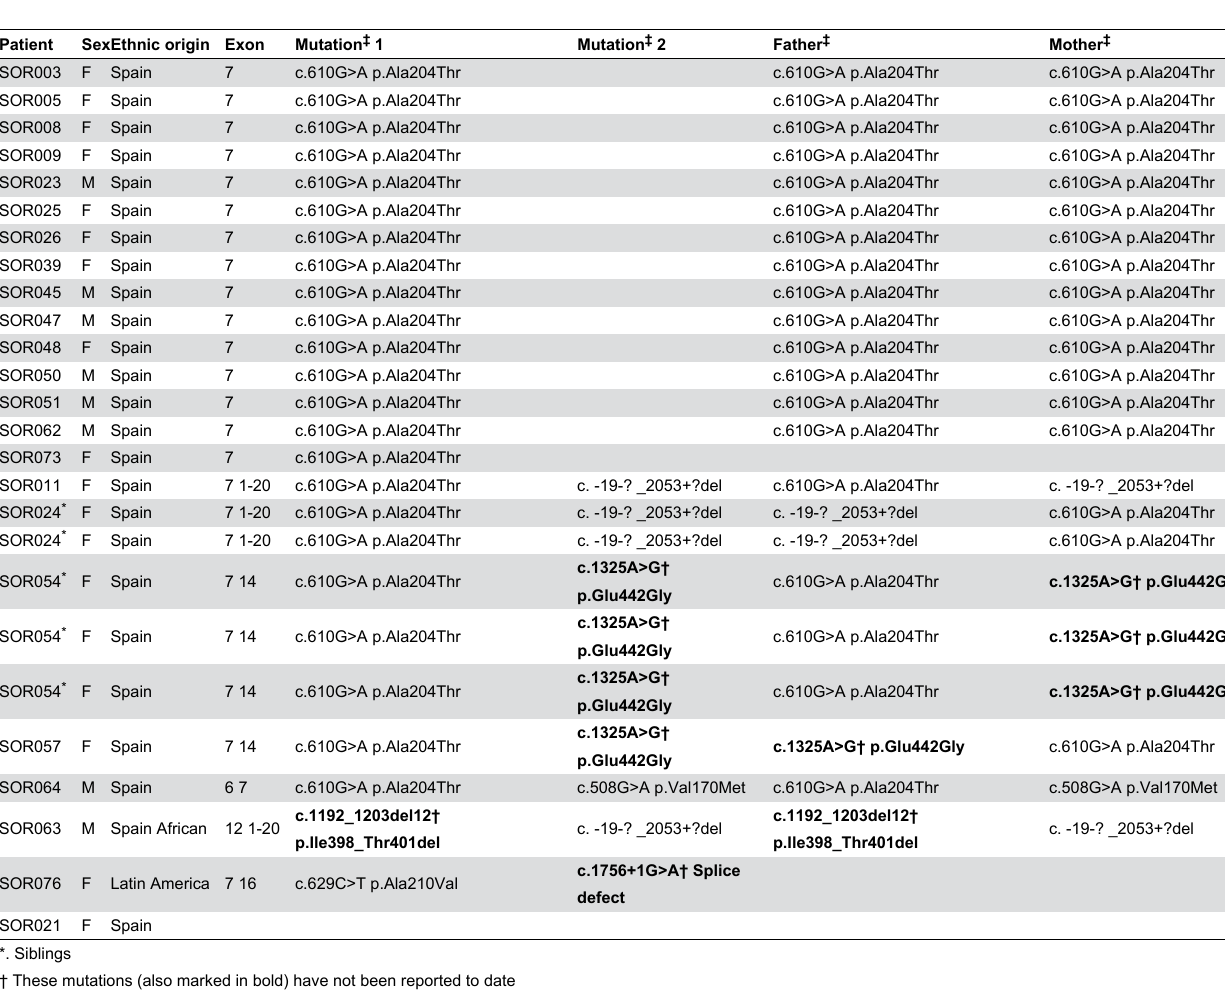
Table 4. Molecular results for the CLCNKB gene in the studied